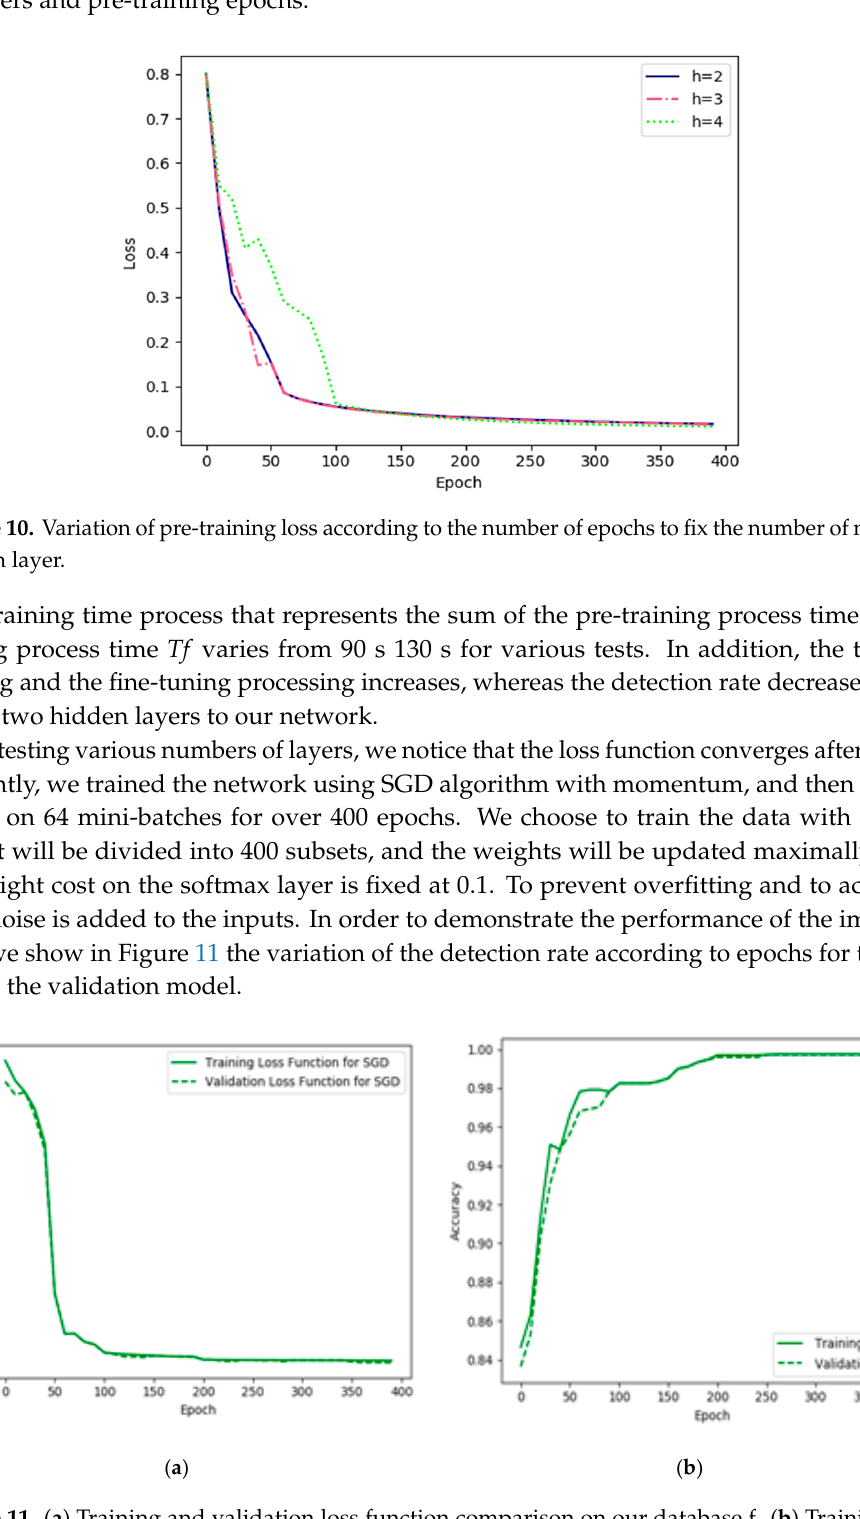
Figure 11. ( a ) Training and validation loss function comparison on our database f. ( b ) Training and validation accuracy comparison on our database.